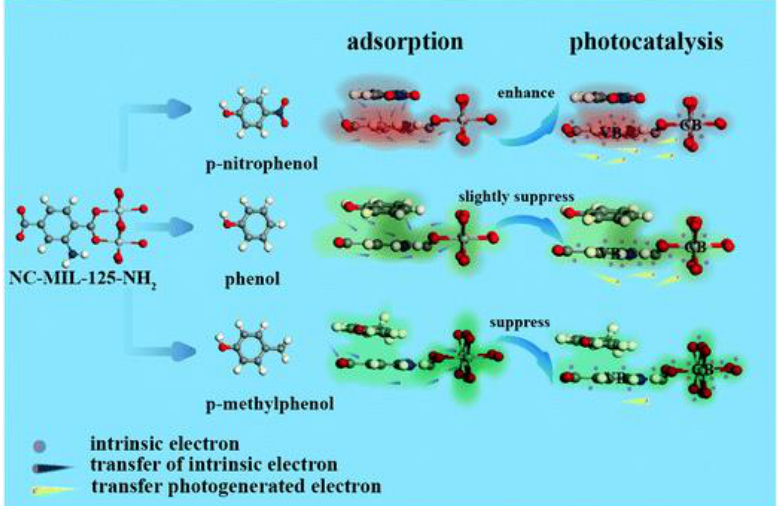
Figure 4. Schematic of the electron-density-induced structure-performance relationship between phenolic molecules and NC-MIL-125-NH 2 in adsorption-photocatalysis [47]. Copyright, 2020 Royal Society of Chemistry.